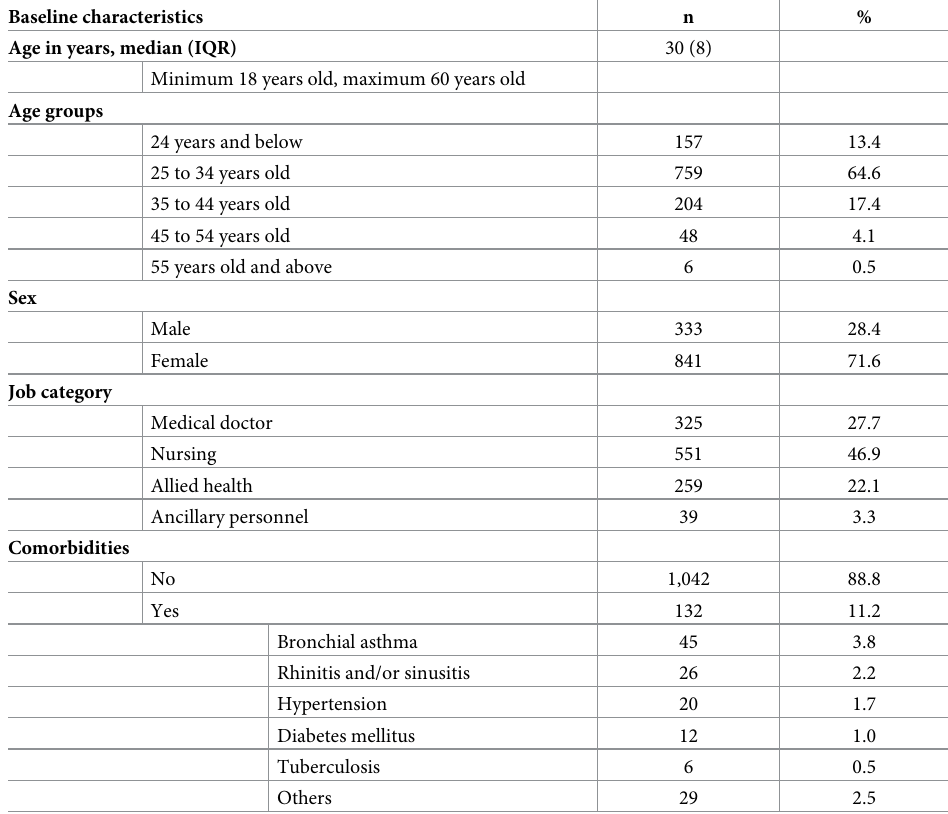
Table 1. Baseline characteristics for all HCW who had work-related exposure (n =